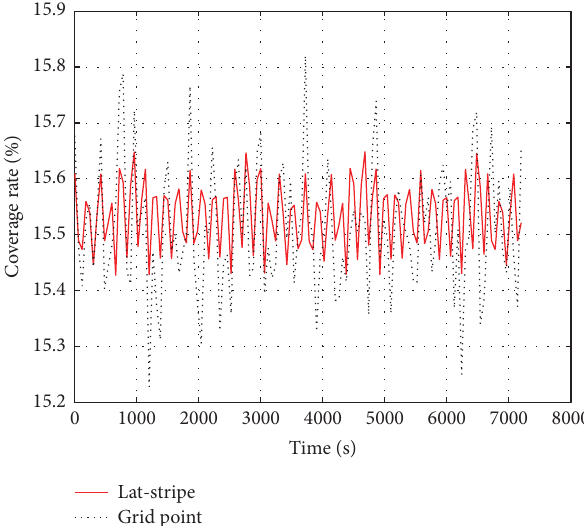
Figure 5: The variation of coverage rate when division granularity is 1 ∘ .